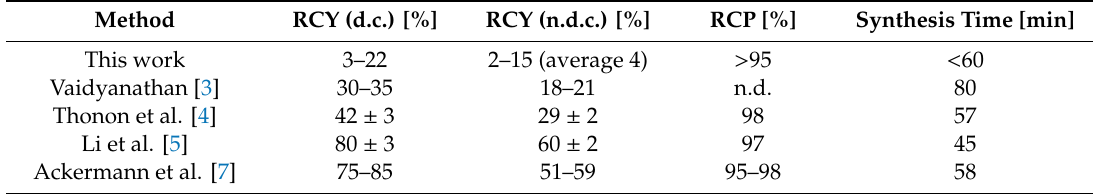
Figure 3. ( A ) [ 18 F]SFB synthesized in 1-step after HPLC purification. Reference compound is co-injected for chemical identification purposes. ( B ) [ 18 F]SFB reacted with FVIIai and purified with a PD10 column. Table 2. Comparison of published [ 18 F]SFB